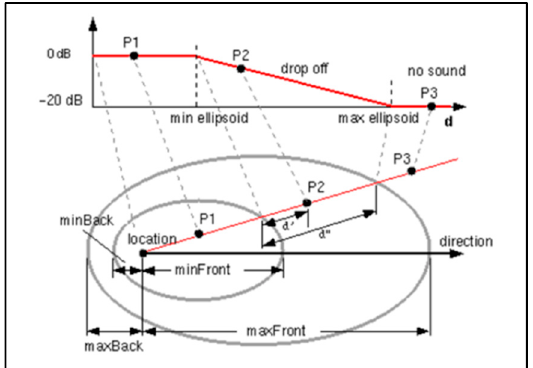
Figure 4. Distance model. From Extensible 3D (X3D), Part 1: Architecture and base components, sound component [21].